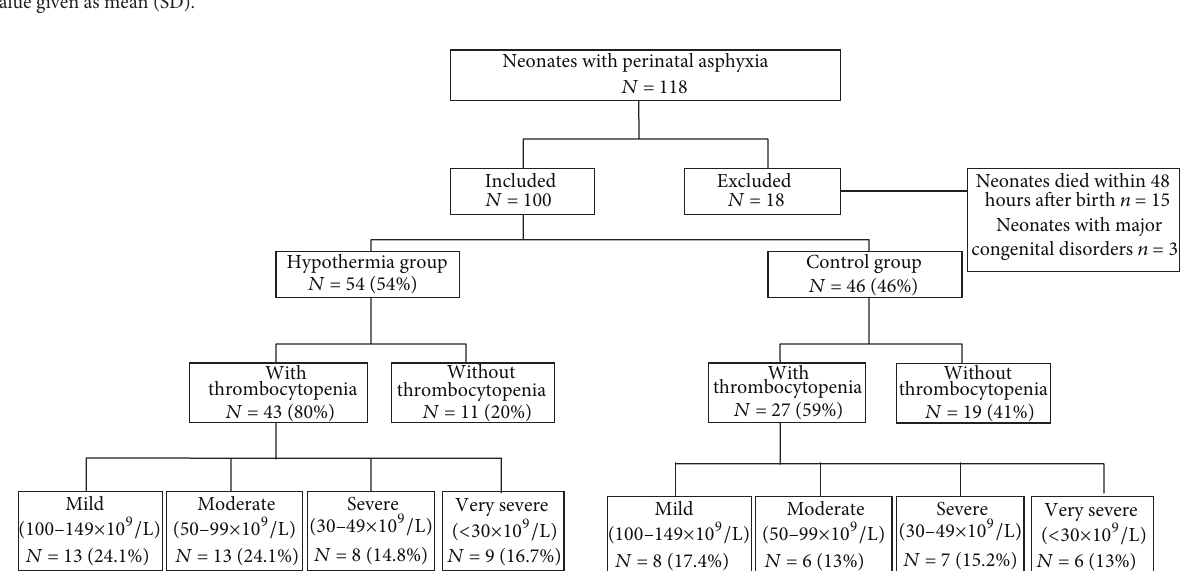
Figure 1: Flowchart showing the derivation of our population and the severity of thrombocytopenia.